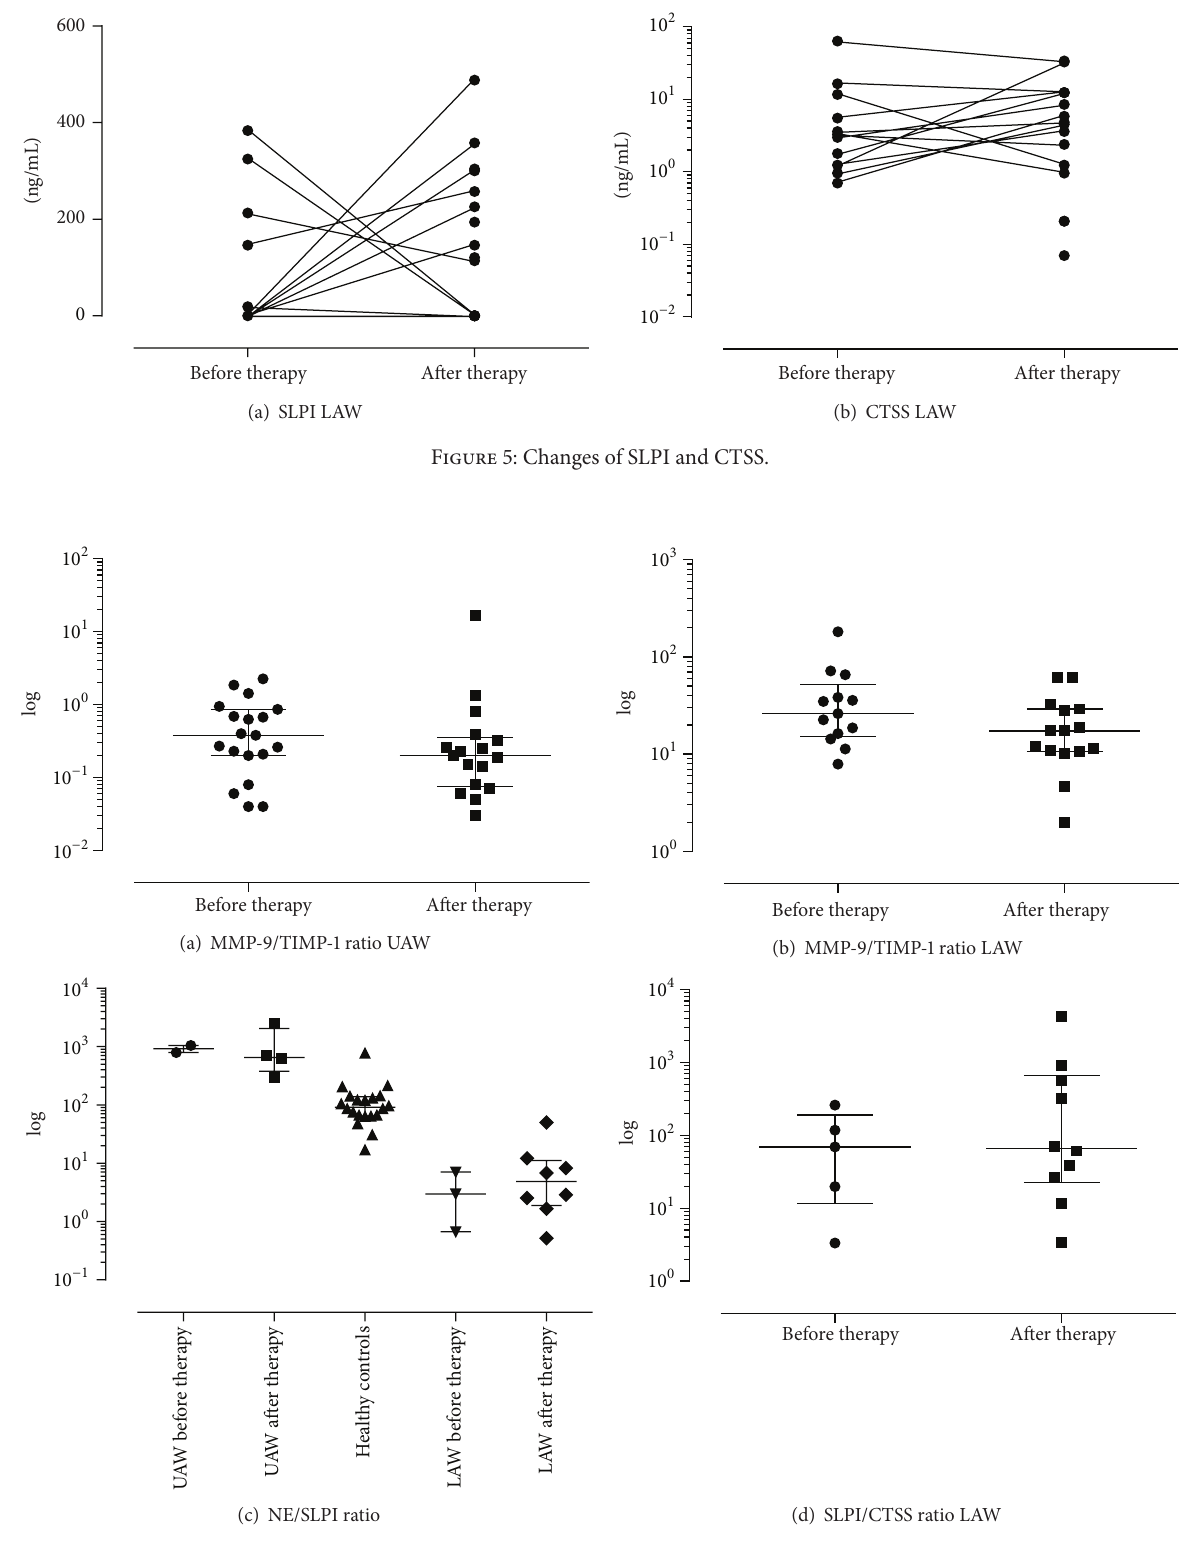
Figure 6: Ratios of proteases and antiproteases: MMP-9/TIMP-1 ratio (a) was higher in the LAW (b), whereas NE/SLPI ratio (c) was higher in the UAW and in healthy controls. SLPI/CTSS (d) was only calculable in the bronchial compartment for low detection rates of both parameters in the UAW. For all of these ratios in UAW and LAW changes did not reach statistical significance. 1 = before therapy; 2 = after